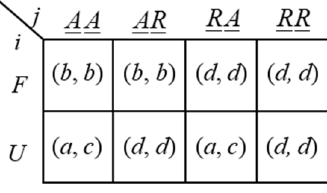
Figure 15. Ultimatum Minigame as original game G .